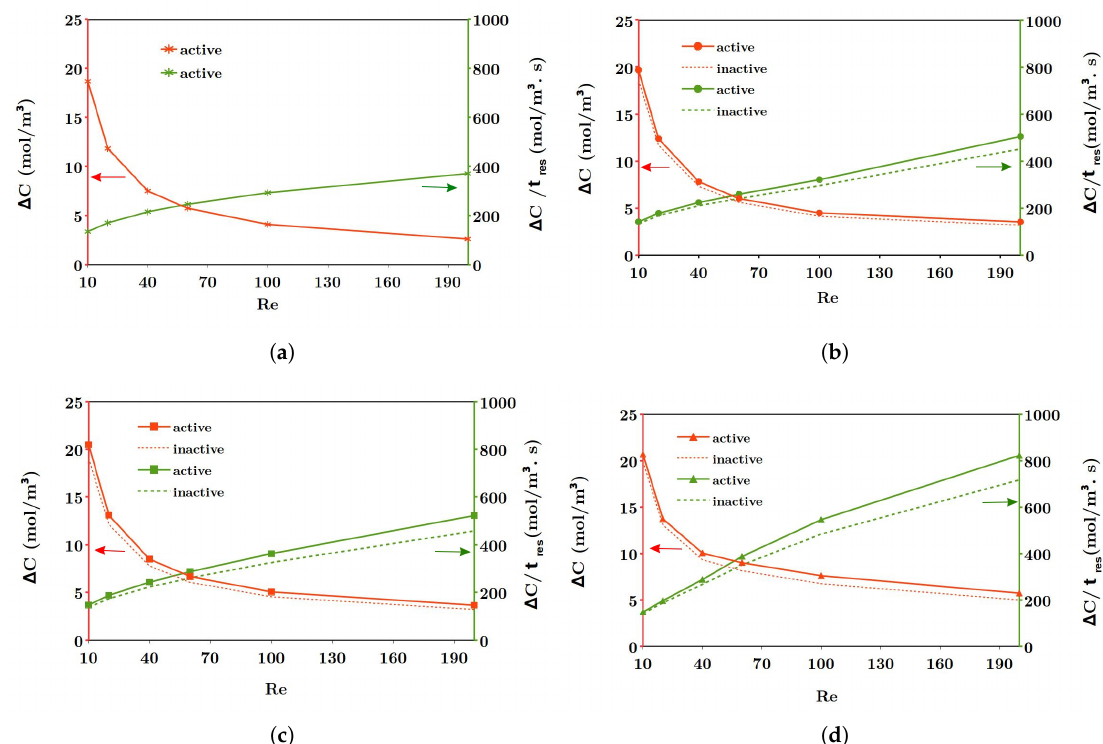
Figure 12. Concentration difference between inlet and outlet of active and inactive spacer-filled channels and normalized concentration with respect to residence time for different geometries at T = 20 ◦ C: ( a ) a flat channe;l ( b ) cylindrical spacer-filled channel; ( c ) square spacer-filled channel; and ( d ) triangular spacer-filled channel.